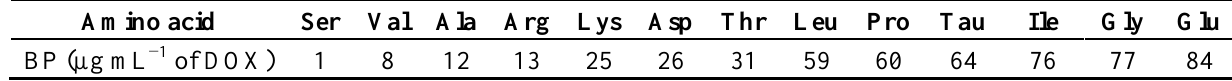
Table 1. Overview of the breaking points expressing the lowest concentration of doxorubicin